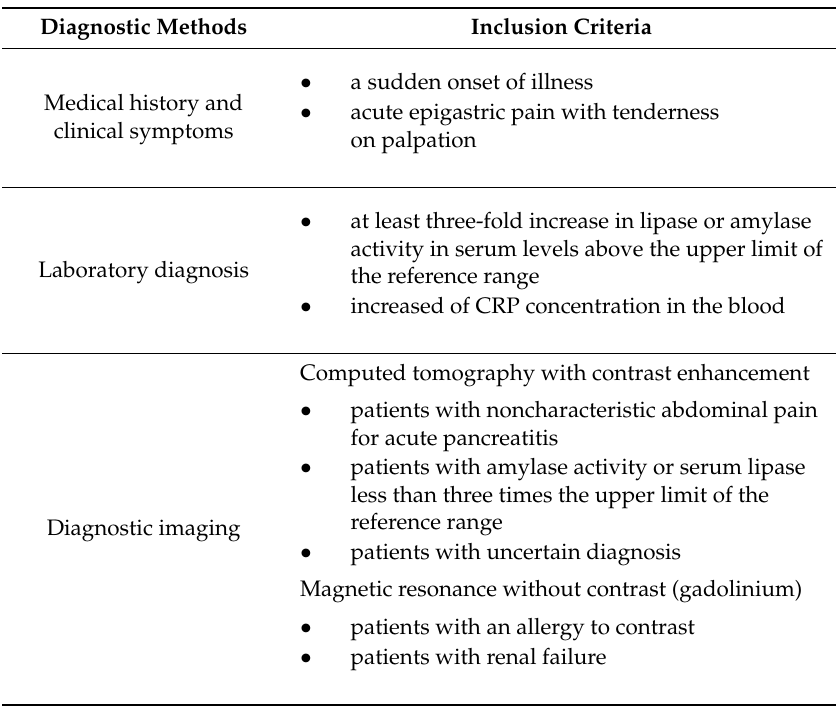
Table 1. Criteria for the inclusion the patients with AP for participation in the